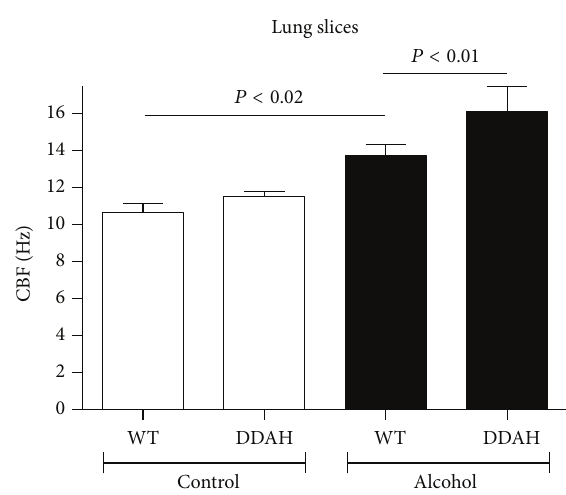
Figure 5: Alcohol-stimulated increases in lung slice airway CBF are enhanced in DDAH mice. Precision-cut lung slices from both wild type (WT) and dimethylaminohydrolase (DDAH) expressing mice were treated with alcohol, and their maximal CBF stimulation peaks were recorded. Alcohol (EtOH; 100 mM) significantly stim- ulated CBF in slices from both mice. Alcohol-stimulated CBF was significantly enhanced in DDAH (30min) versus WT lung slices (1hr). Bars represent SEM of triplicate separate experiments ( 𝑛 = 3